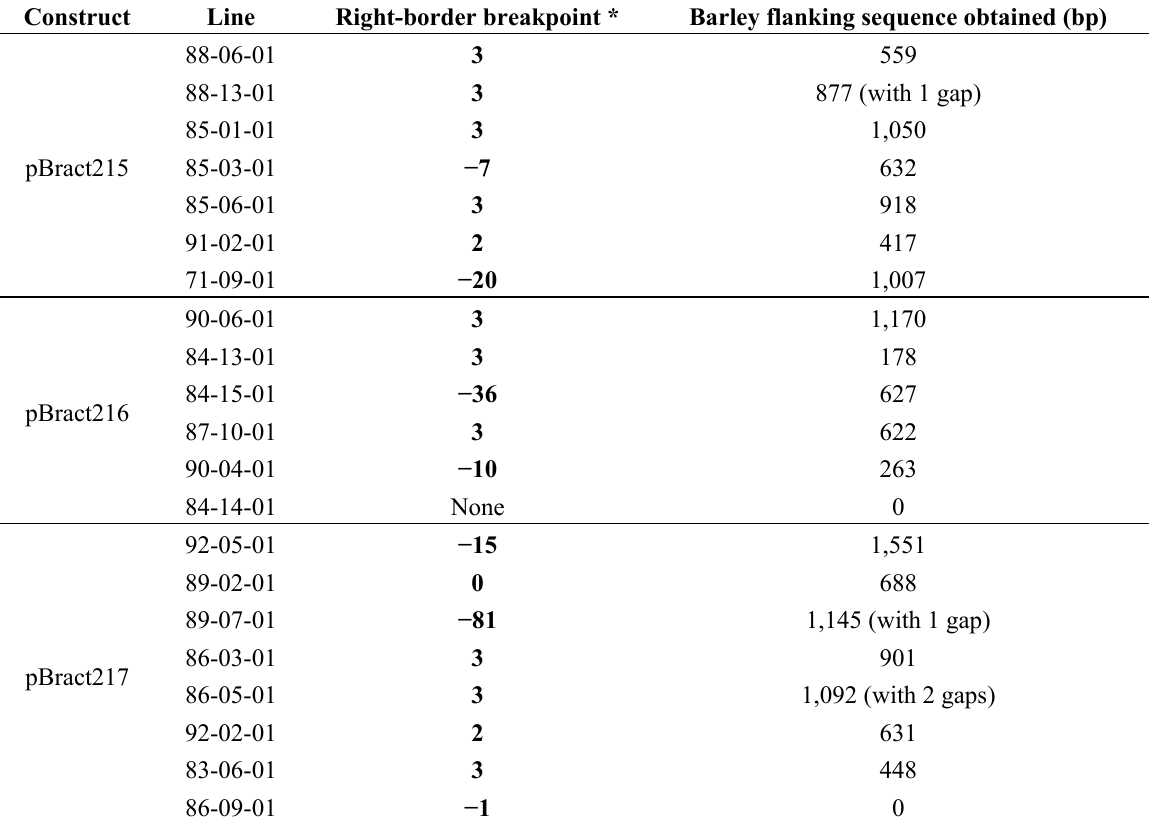
Table 2. Right-border breakpoints and the amount of barley genomic flanking DNA obtained. Construct Line Right-border breakpoint * Barley flanking sequence obtained (bp)